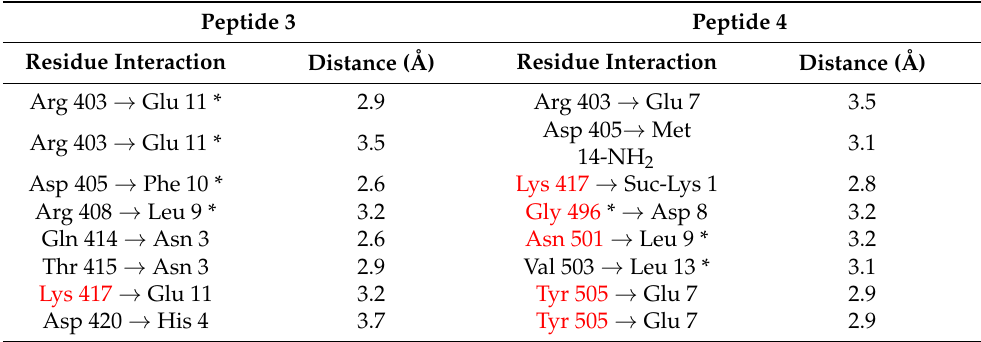
Table 3. Binding sites between Peptides 3 and 4 and the spike protein RBD. Peptide 3 Peptide 4 Residue Interaction Distance (Å) Residue Interaction Distance (Å) Arg 403 → Glu 11 *